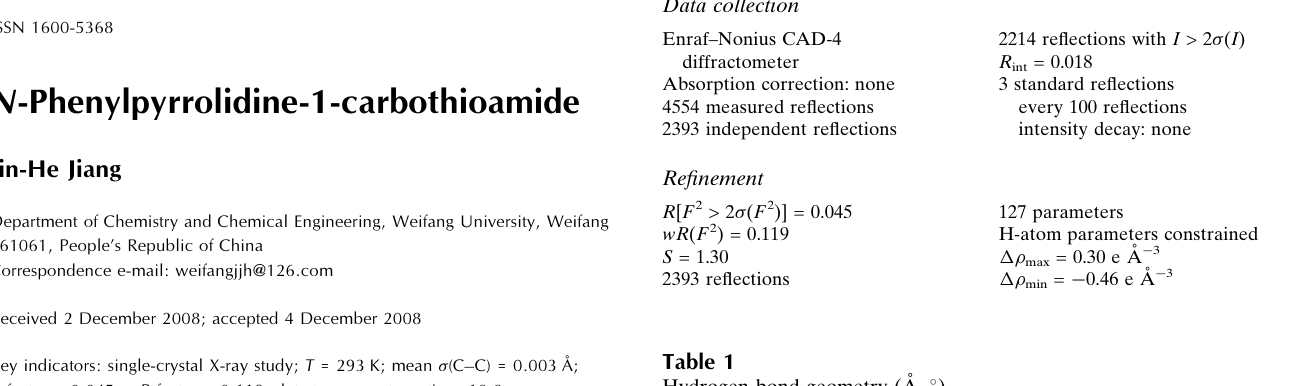
Hydrogen-bond geometry (A˚ , (cid:2)